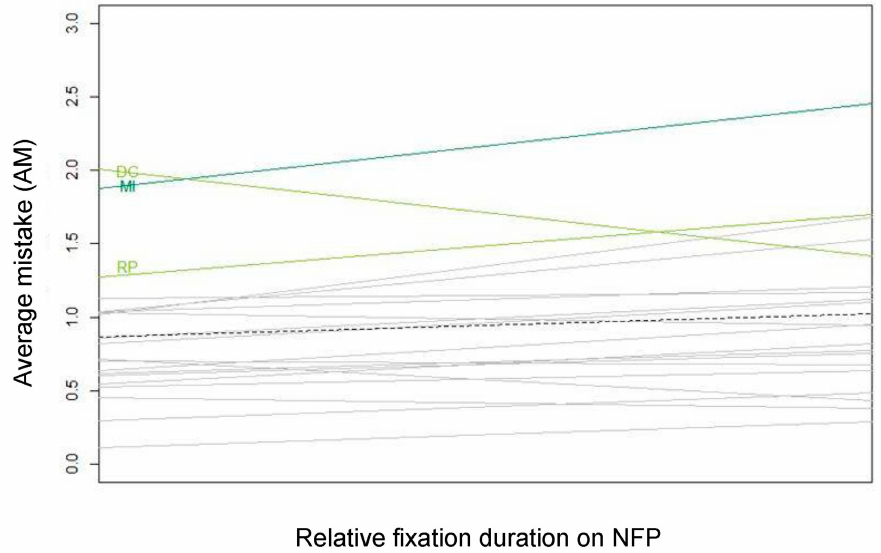
Figure 14. By-stimulus regression slopes for relative fixation duration on NFP in the subset of participants exposed to products with NFP. Abbreviations of the product names are explained in Figure 4 and in Appendix A (Table